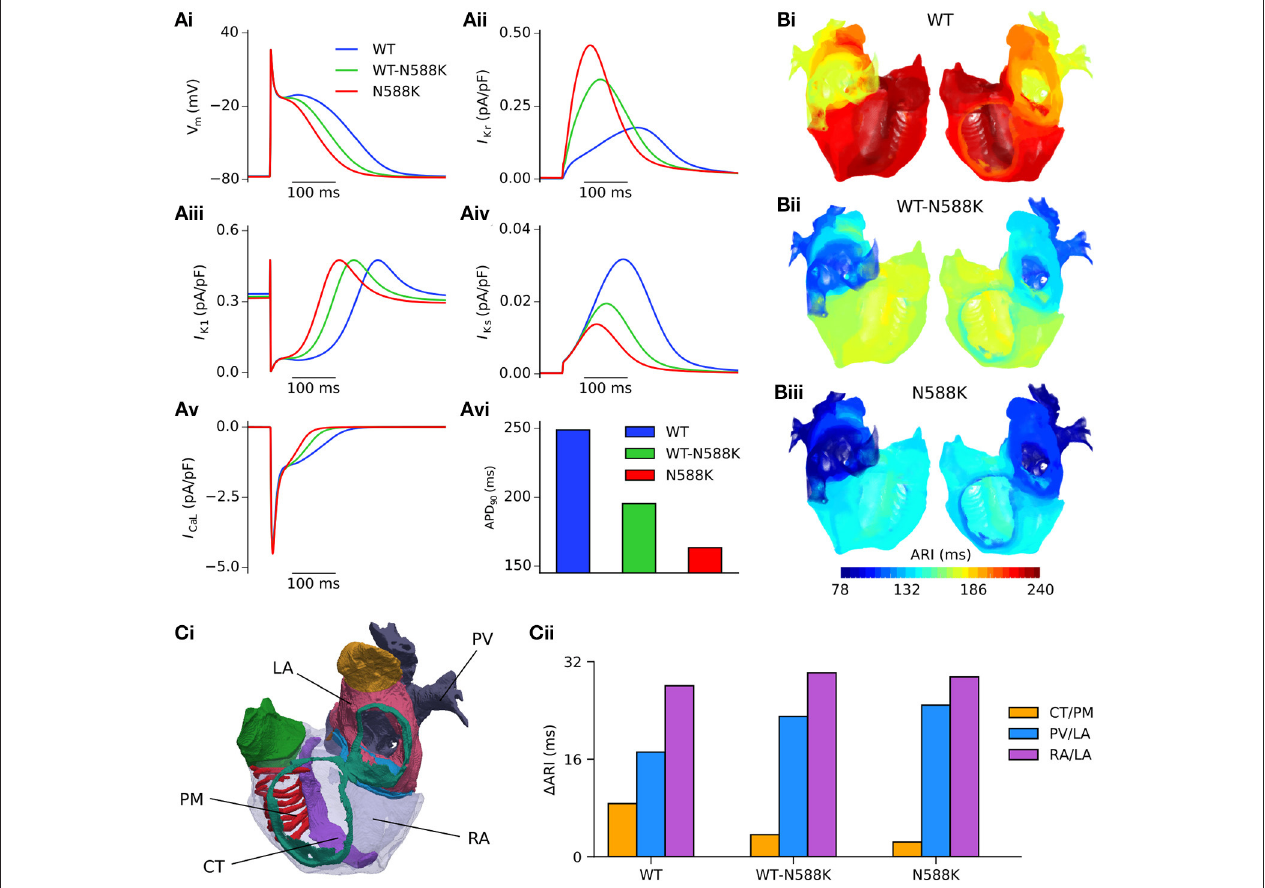
FIGURE 3 | Effects of the N588K-hERG mutation at the single cell and whole human atria level. (Ai) Single cell action potential profiles under WT (blue), WT-N588K (green), and N588K (red) conditions at a pacing frequency of 1Hz, with corresponding current traces for (Aii) I Kr , (Aiii) I K1 , (Aiv) I Ks , and (Av) I CaL , and (Avi) a summary of the measured APD 90 . (B) Activation-recovery interval (ARI) maps under (i) WT, (ii) WT-N588K, and (iii) N588K conditions. (Ci) View looking into the cavities of the 3D anatomical human atria model, with the following regions highlighted: crista terminalis (CT), left atrium (LA), pectinate muscles (PM), pulmonary veins (PV), and right atrium (RA). (Cii) Measured dispersion of activation-recovery interval, 1 ARI, between different atrial regions under WT and SQT1 mutation